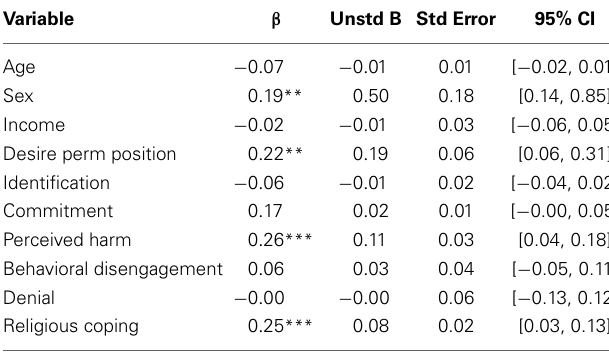
Table 6 | Correlations of DASS variables with demographic variables, commitment, identification, stressors, harm, and COPE variables. Variable Depression Anxiety Stress